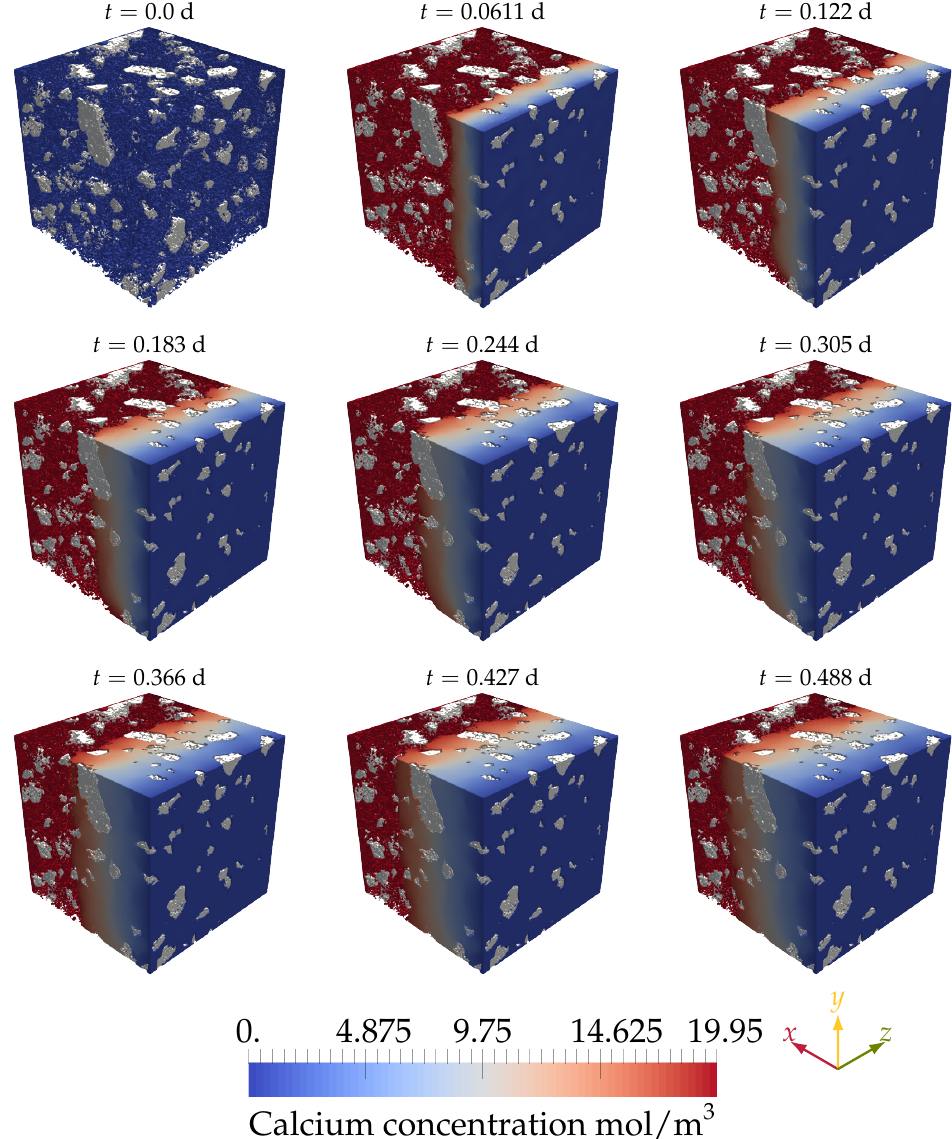
Figure 10. The progression of the calcium leaching front in the HCP. Starting from zero concentration, the pore water reaches its saturation level shortly after the start of the simulation. At the plane x = 0, zero concentration was imposed to simulate the existence of an aggressive solution (de-ionized water). The irregular shapes in white are the unhydrated cement